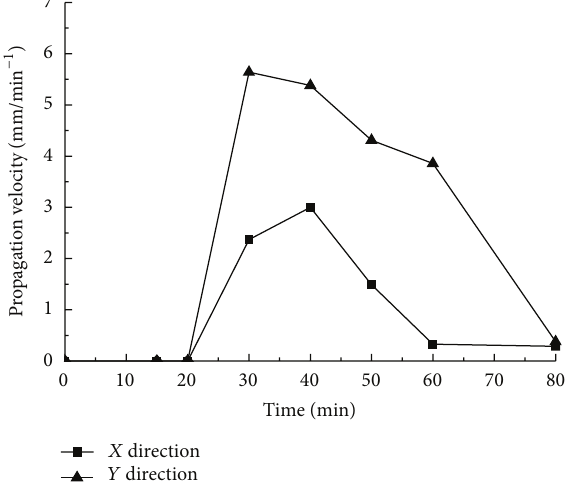
Figure 7: The relation curves between the average expansion velocities of cracks A and B and